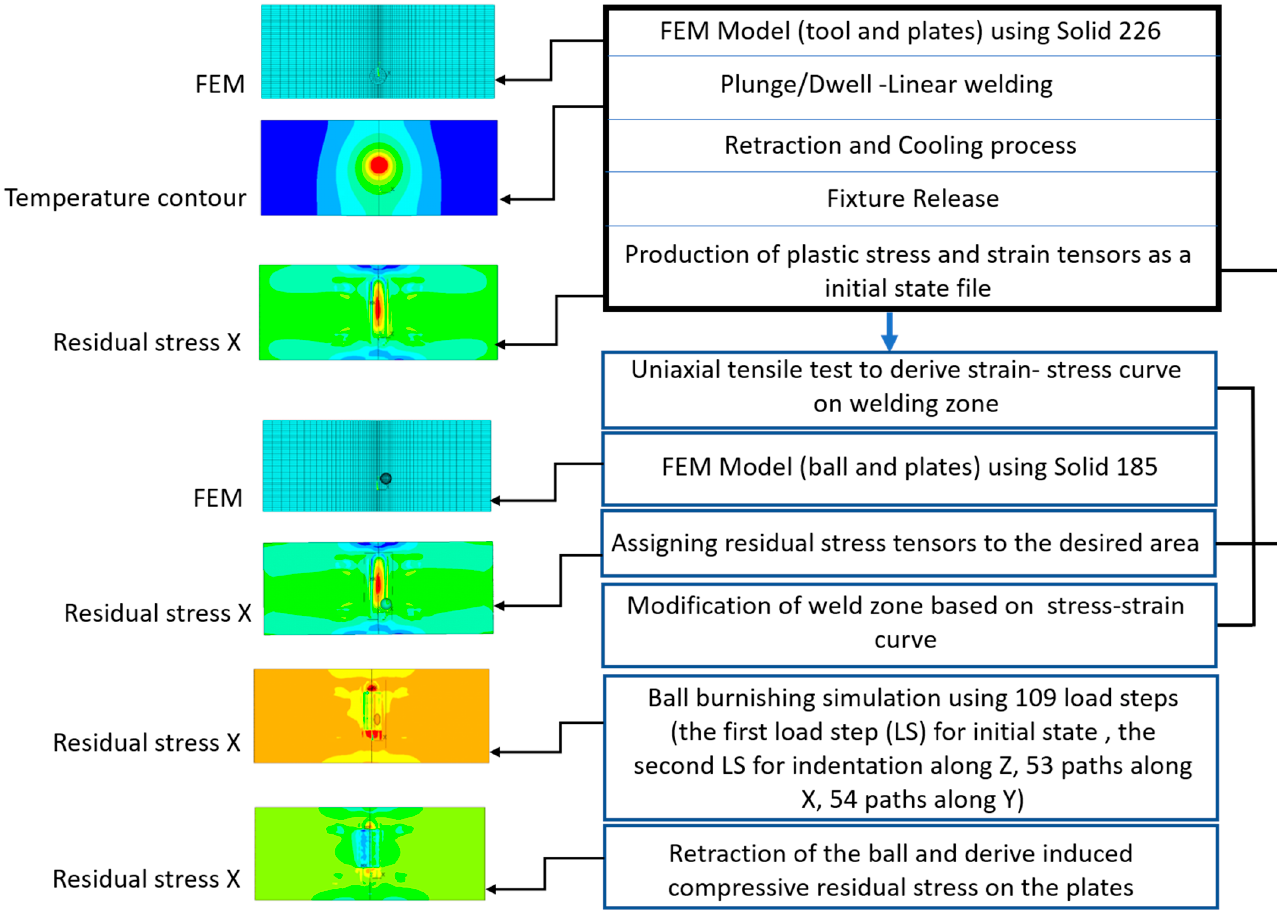
Figure 6. Flowchart representing the simulation steps from FSW to BB process.